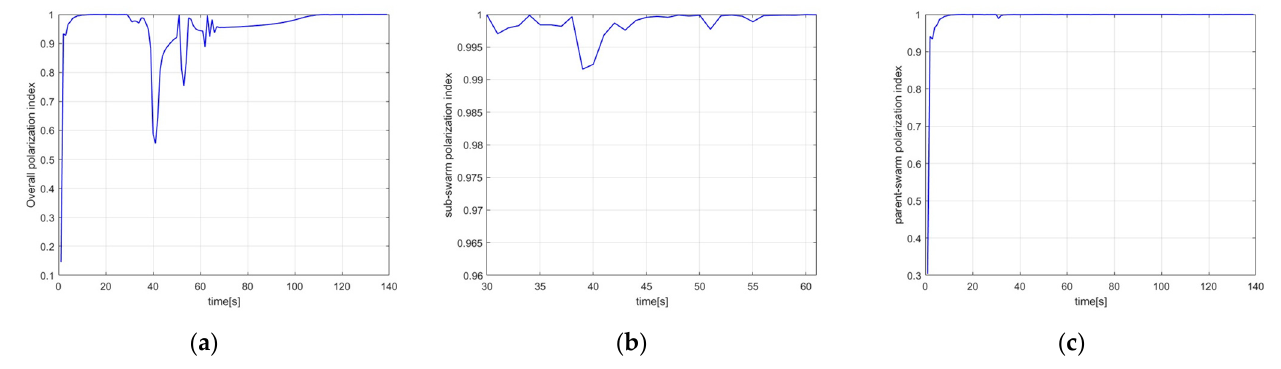
Figure 7. Polarization indices in the fission–fusion process of UAV swarm under the anti-catch situation. ( a ) overall polarization index; ( b ) sub-swarm polarization index; ( c ) parent swarm polarization index.